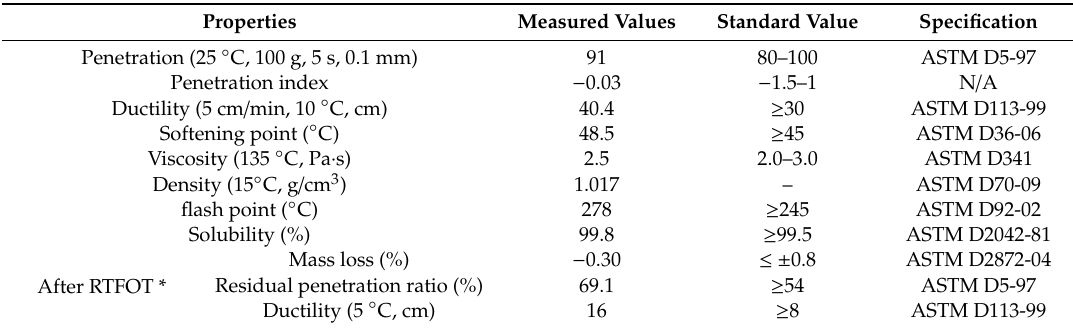
Table 1. Physical properties of asphalt binder.